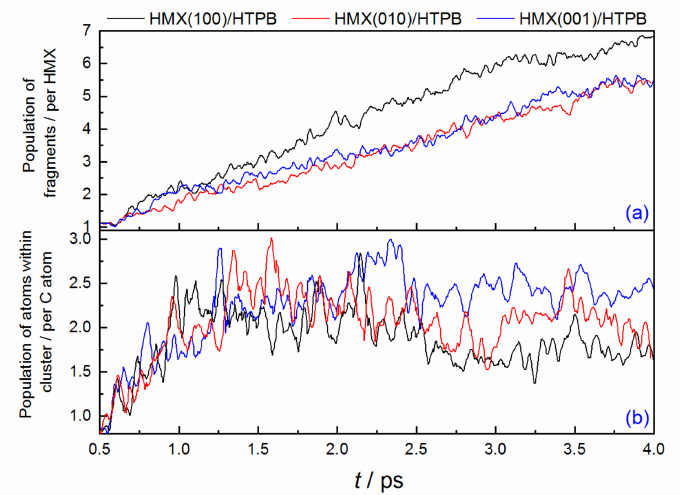
Figure 8. Populations for total fragments ( a ) and atoms in cluster ( b ) involved in different explosives